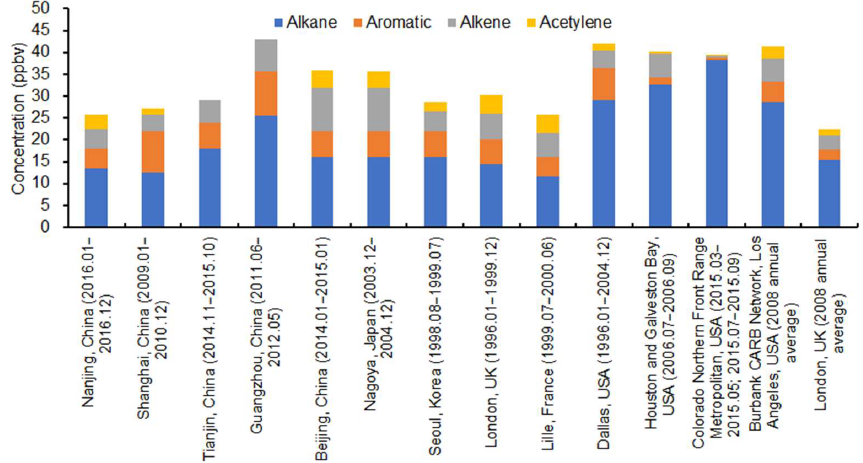
Figure 2. Comparison of annual-average concentrations of ambient VOC in different cities based on real-time online continuous measure- ments of at least 1 year.